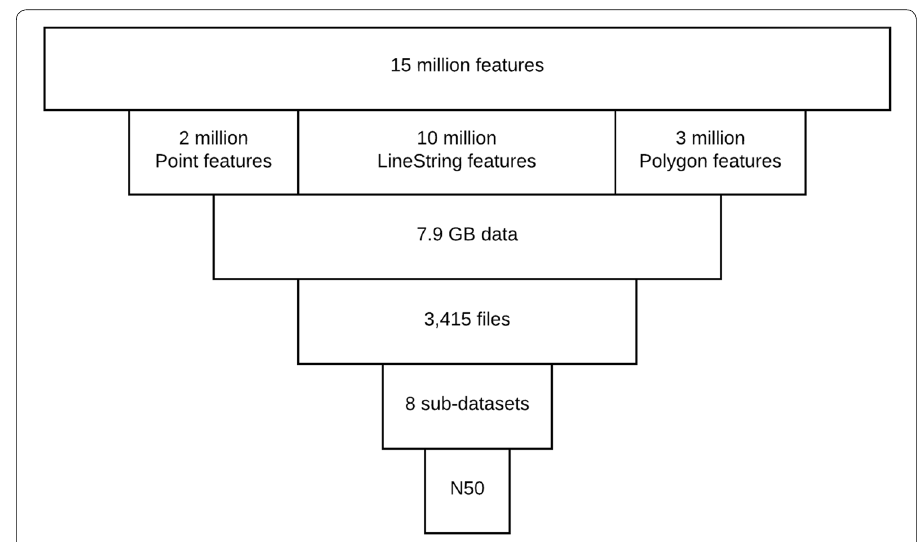
Fig. 5 Overview of the N50 dataset